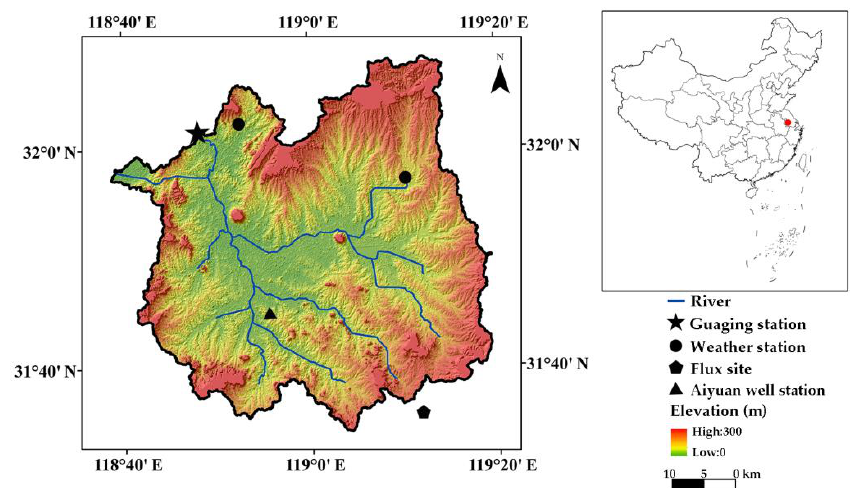
Figure 1. Digital elevation model and locations of eddy flux measurement, standard weather stations, well station, and hydrologic gauging stations measuring streamflow in the Qinhuai River Basin, southern China.